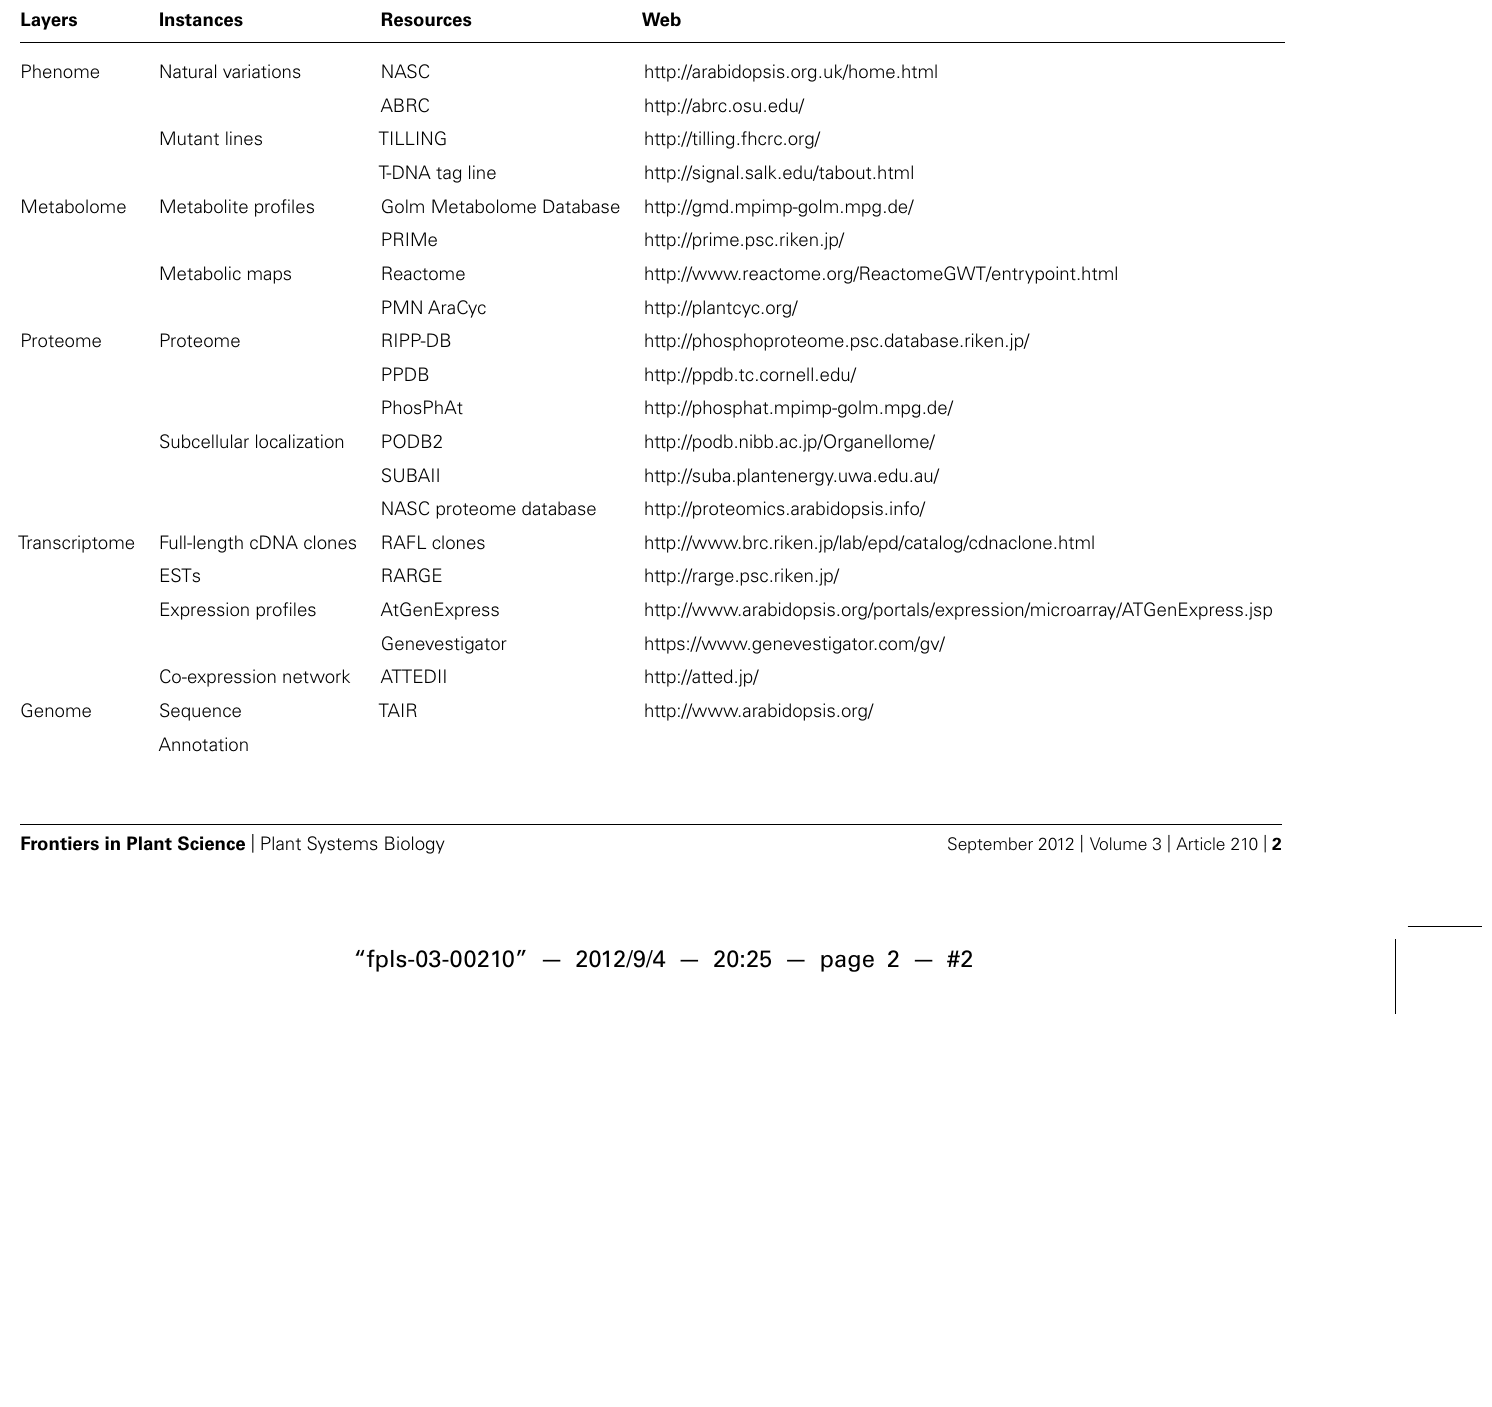
Table 1 | Omics fields associated with illustrative and available Arabidopsis resources on web.